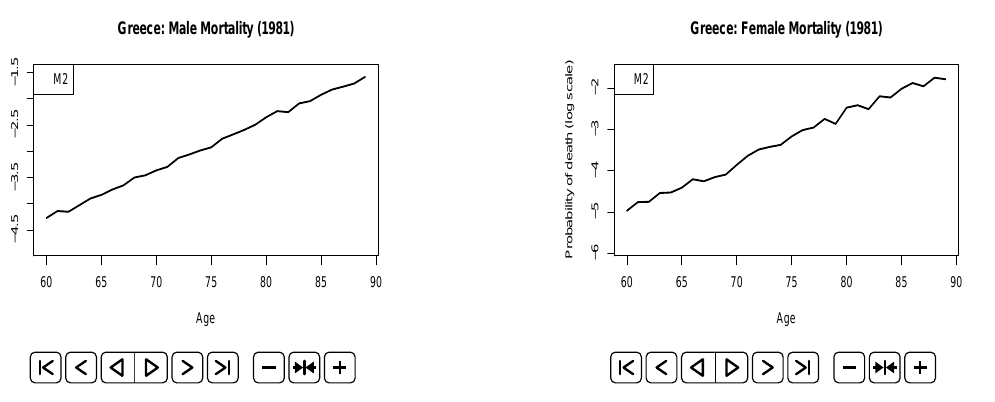
Figure A2. M 2 for males and females.